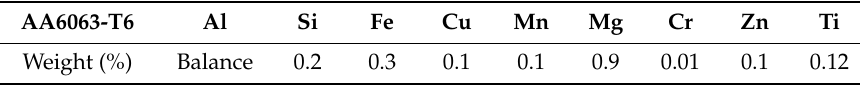
Table 1. Chemical composition (wt.%) of